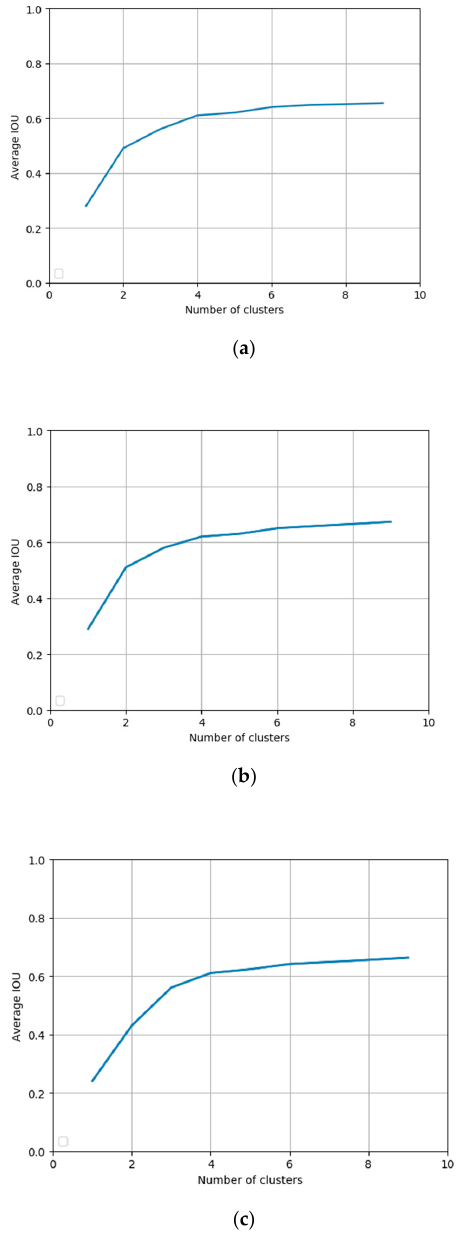
Figure 13. The relationship between number of clusters and average insertion over union (IOU) by K-means clustering, ( a ) The curve of RSOD dataset, ( b ) The curve of UCS-AOD dataset, ( c ) The curve of VEDIA dataset.